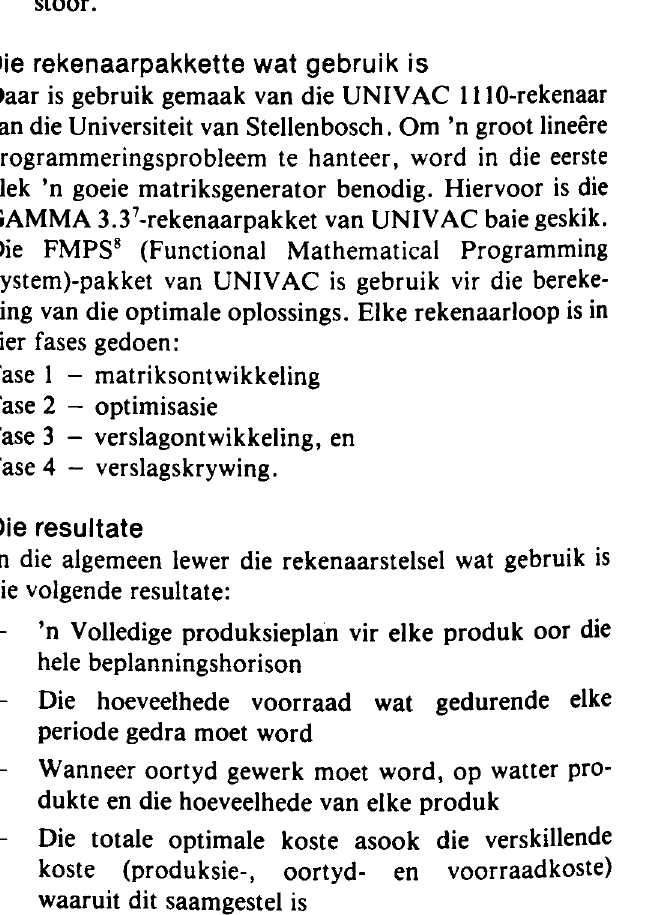
Fig. 2 Die verkoopspatroon van Produk 20 vir drie agtereenvolgende